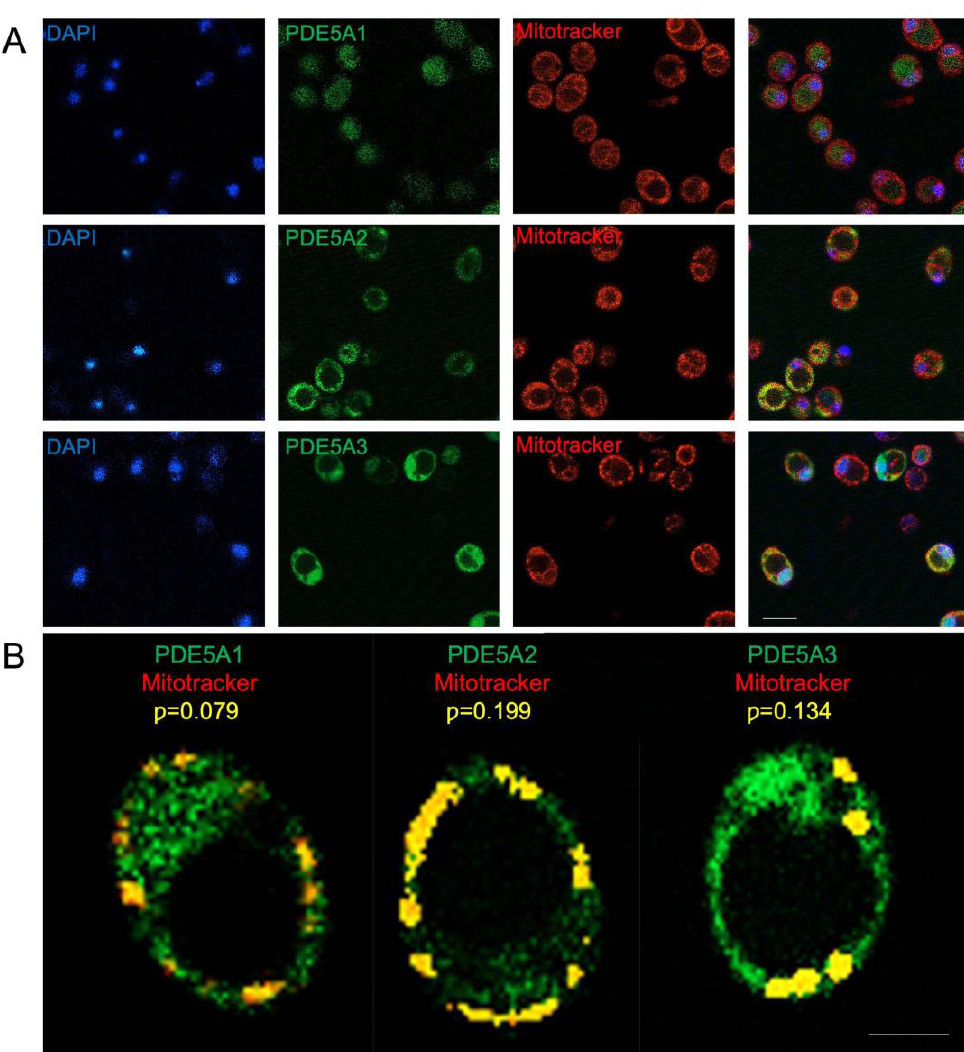
Figure 4. Fluorescence microscopy images of K. lactis cells overexpressing MmPDE5AGFP isoforms. ( A ) Intracellular localization of MmPDE5A1, A2, and A3 isoforms revealed in cell transformed with GFP-tagged isoform constructs (green). Cultures were grown to early stationary phase in YP containing 2%Glc + G418; cells stained with DAPI (blue) and MitoTracker (red) were visualized under the confocal microscope. Scale bar: 10 µm. ( B ) Colocalization analysis on K. lactis cells overexpressing MmPDE5A-GFP isoforms. Cells overexpressing GFP-tagged MmPDE5A1, A2, and A3 isoforms (green) were grown to early stationary phase in 2%Glc + G418 and stained with MitoTracker (red). Images showing a representative single cell, were acquired using a Zeiss LSM 800 System. Colocalization signal (yellow) was quantified using the Pearson correlation coefficient ( p ). Original magnification 20×; Inset 10×; Scale bar: 5 μm.